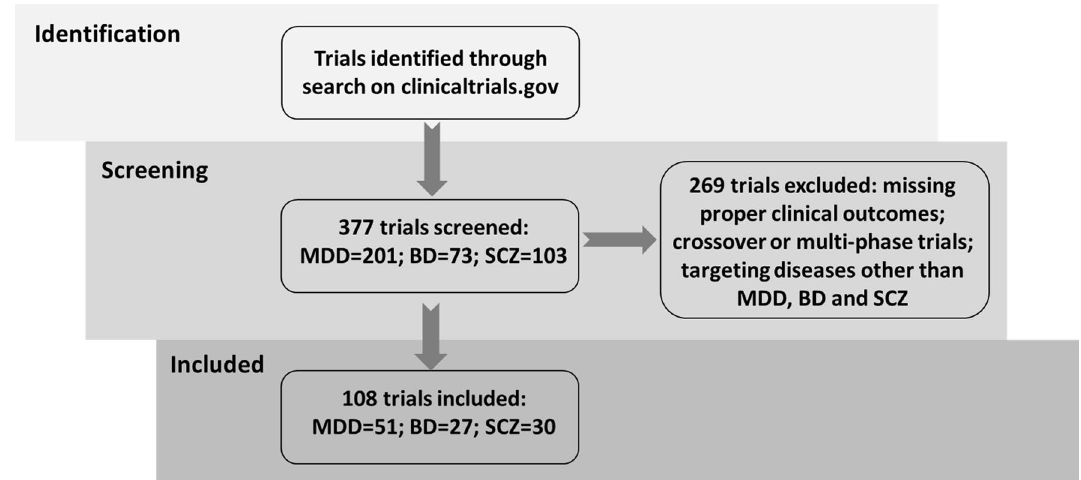
Figure 1. Searching and screening process of clinical trials. MDD major depressive disorder, BD bipolar disorder, SCZ schizophrenia.